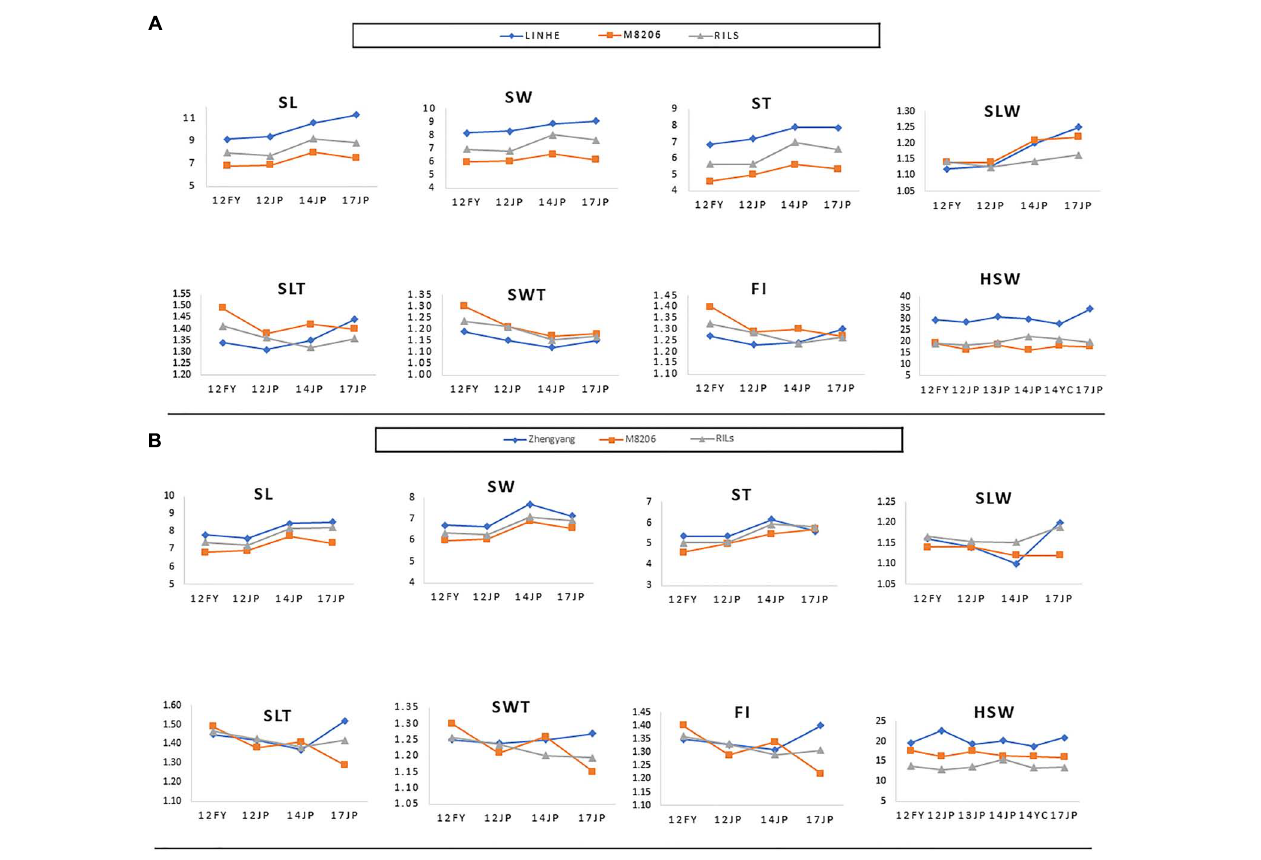
FIGURE 4 | Performance of the parents of the two RIL populations, i.e., LINHE and M8206 (A) and Zhengyang and M8206 (B) along with the two derived RIL populations, LM6 and ZM6, respectively for seed size and shape traits as well as 100-seed weight among multiple environments. 12JP, 13JP, 14JP, and 17JP indicate phenotyping at the Jiangpu Experimental Station in the 2012, 2013, 2014, and 2017 growing seasons, respectively. 12FY indicates the Fengyang Experimental Station, Chuzhou in the 2012 growing season. 14YC indicates the Yancheng Experimental Station in 2014. SL, seed length (mm); SW, seed width (mm); ST, seed thickness (mm); SLW, seed length to width ratio; SLT, seed length to thickness ratio; SWT, seed width to thickness ratio; FI, flatness index; HSW, 100-seed weight (g).